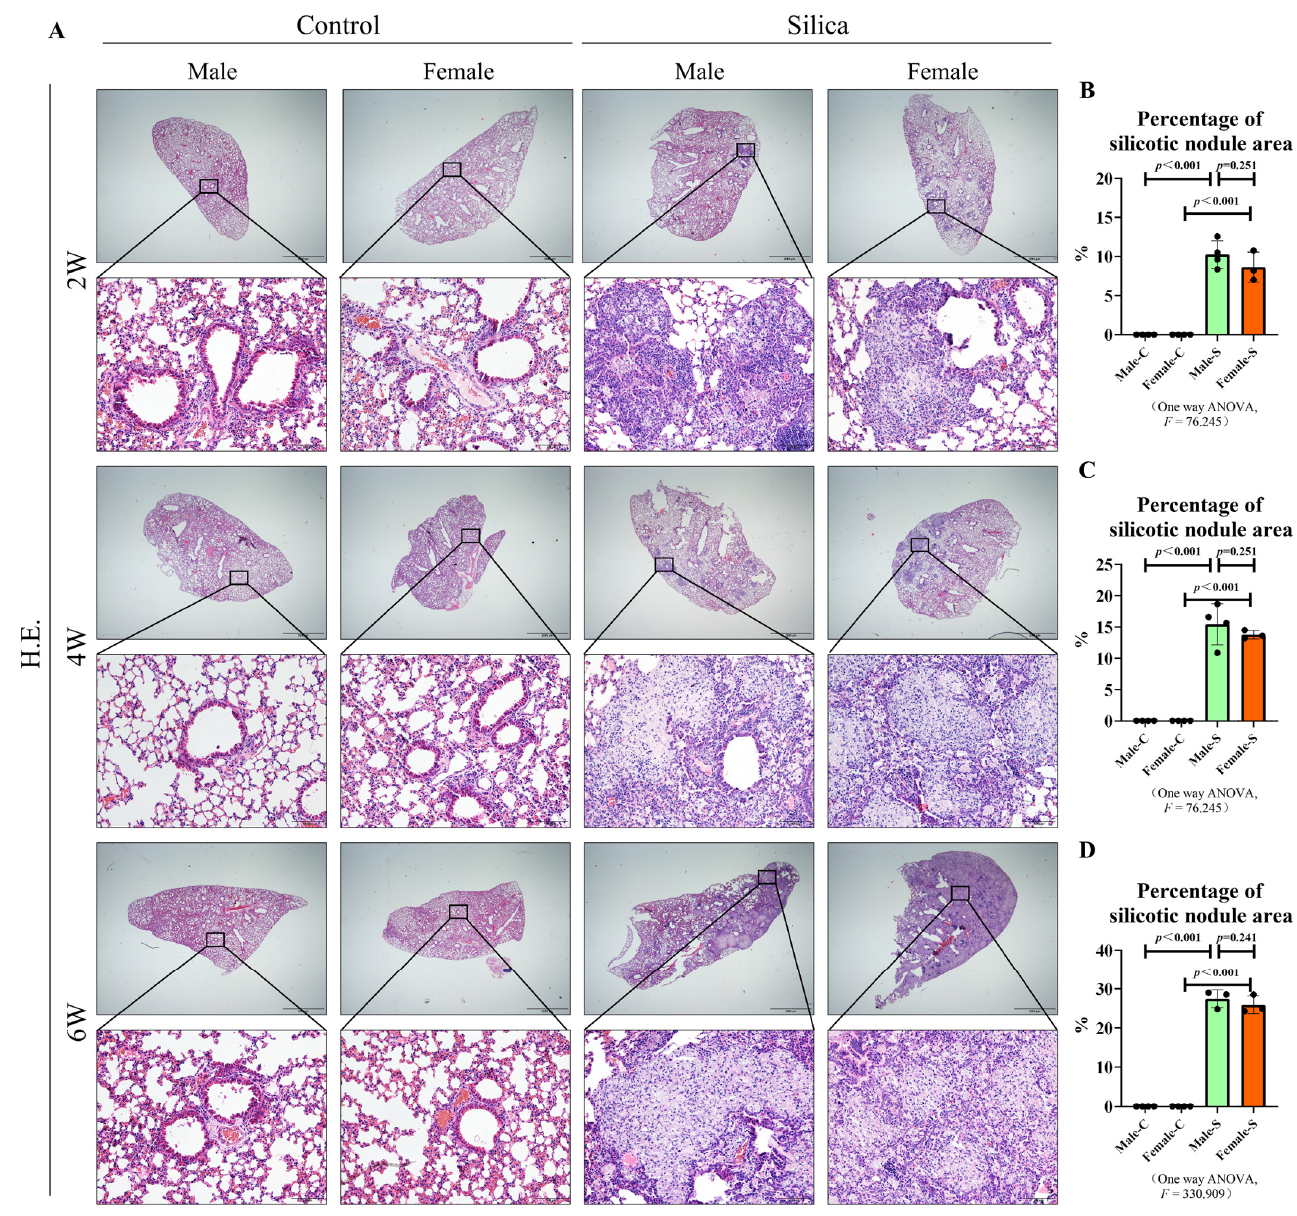
Figure 2. H&E staining of male and female mice exposed to silica in two, four, and six weeks, and the control groups. ( A ) H&E staining of the lung tissues in mice exposed to silica (scale bar = 2000 µm). ( B – D ) Statistical analysis of the H&E staining, n = 5 per group (( B )—2W, ( C )—4W, ( D )—6W).